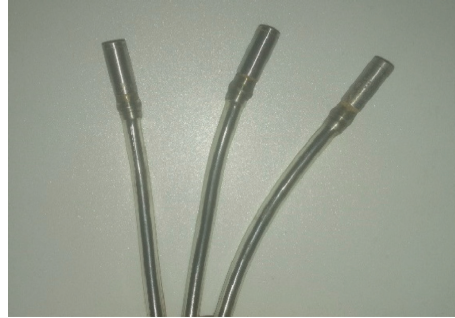
Figure 7: Micropore water pressure sensors.